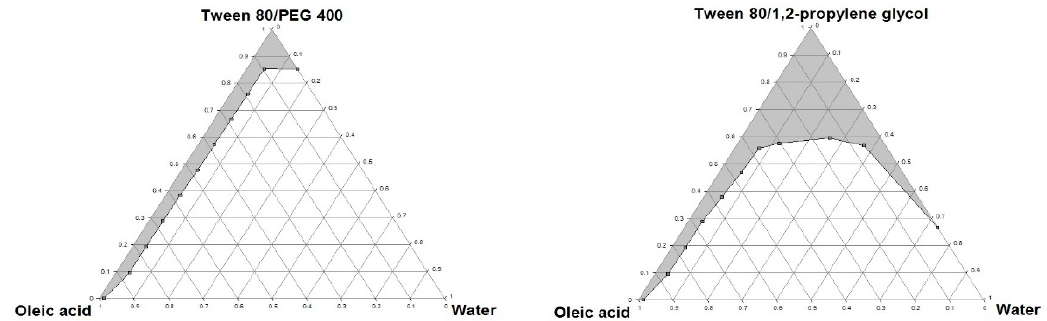
Figure 1. Pseudoternary phase diagrams of mixtures with oleic acid. Tween 80/PEG 400 and Tween 80/1,2-propylene glycol ratio is 1:1. The diagram with the formulation characterized by the best self-emulsifying properties is framed.